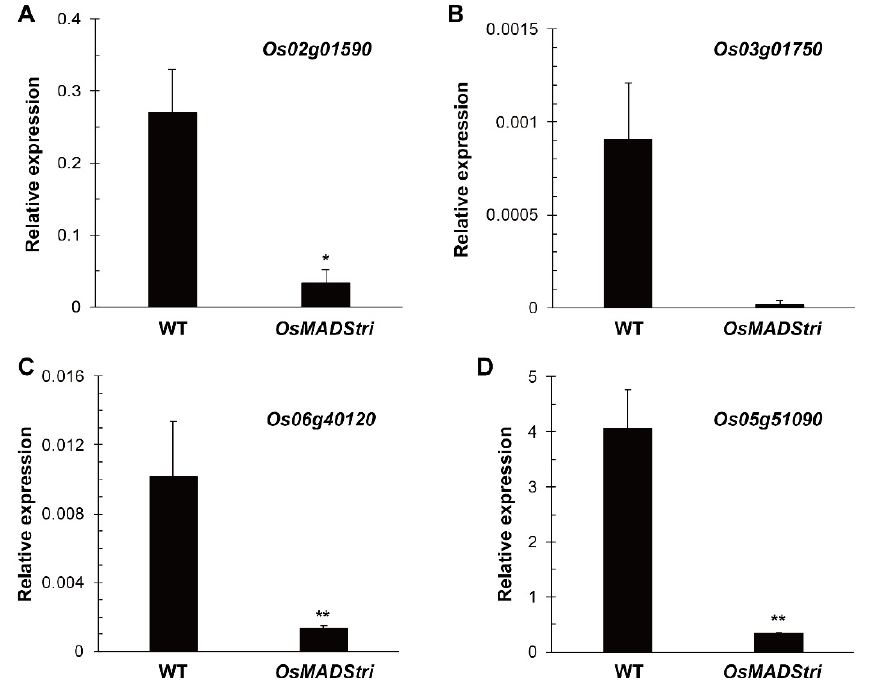
Figure 5. Verifying the expression patterns of four genes ( A ) LOC_Os02g01590, ( B ) LOC_Os03g01750, ( C ) LOC_Os06g40120 and ( D ) LOC_Os05g51090 related to starch accumulation among downregulated genes. The expression value of those genes was verified by RT-qPCR. OsUBI5 (LOC_Os01g22490) was used as an internal control. Error bars indicate the standard deviation of three biological replicates. p -value calculated by one-way Analysis of Variance (ANOVA) with repeated measurements using Tukey’s pairwise comparison test. *, p < 0.1; **, p < 0.01.